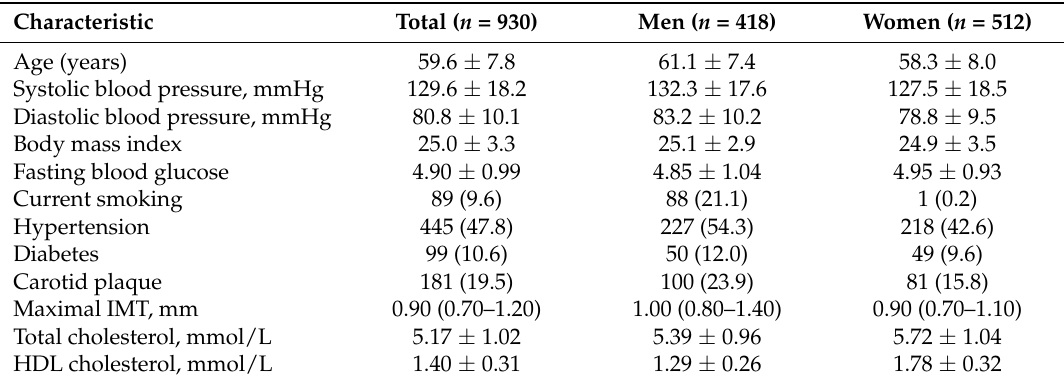
Table 3. Baseline (2002) characteristics of CMCS-Beijing cohort participants followed up in 2007.